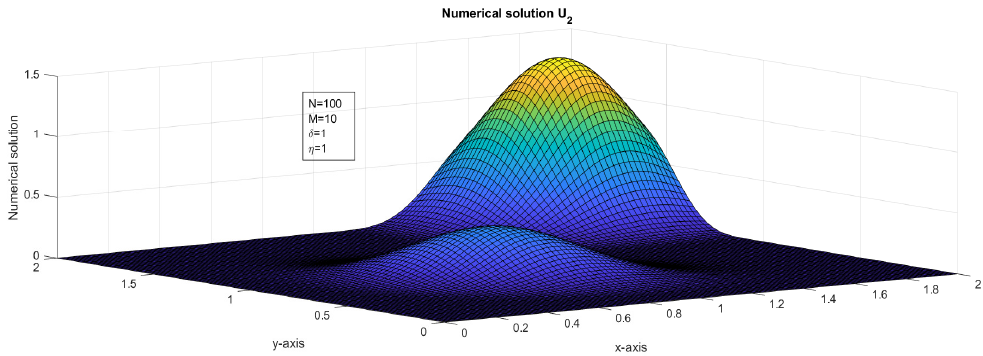
Figure 1. The surface plot illustrates the numerical solution, U 1 , for Case 1 in Example 1.